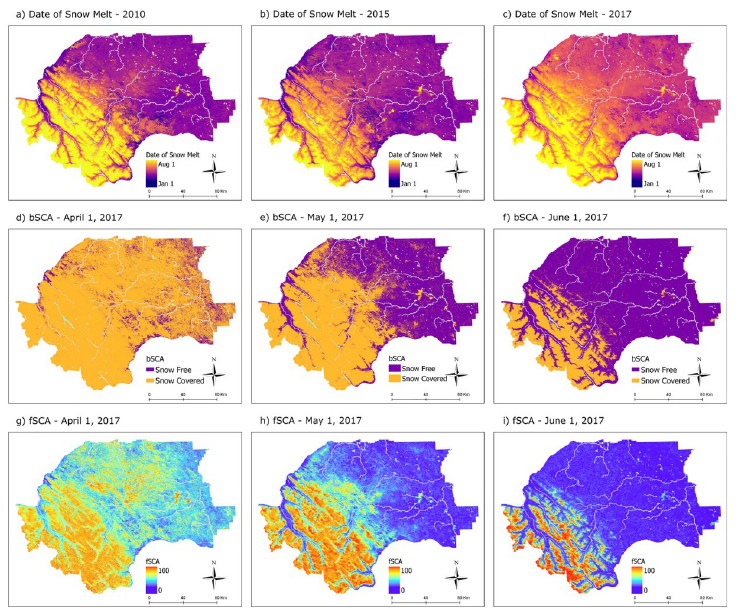
Fig 2. The three snow metrics derived from SNOWARP (Berman et. al., 2018) at 30 m spatial resolution for years 2009–2017. a-c) Annual date of snow melt shown for spring 2010, 2015 and 2017. Days since snow melt (DSM) was produced by subtracting date of snow melt from the date associated with each grizzly bear telemetry location. d-f) daily binary snow covered area (bSCA) shown on April 1, May 1, and June 1, 2017. g-i) daily fractional snow covered area (fSCA) shown on April 1, May 1, and June 1,